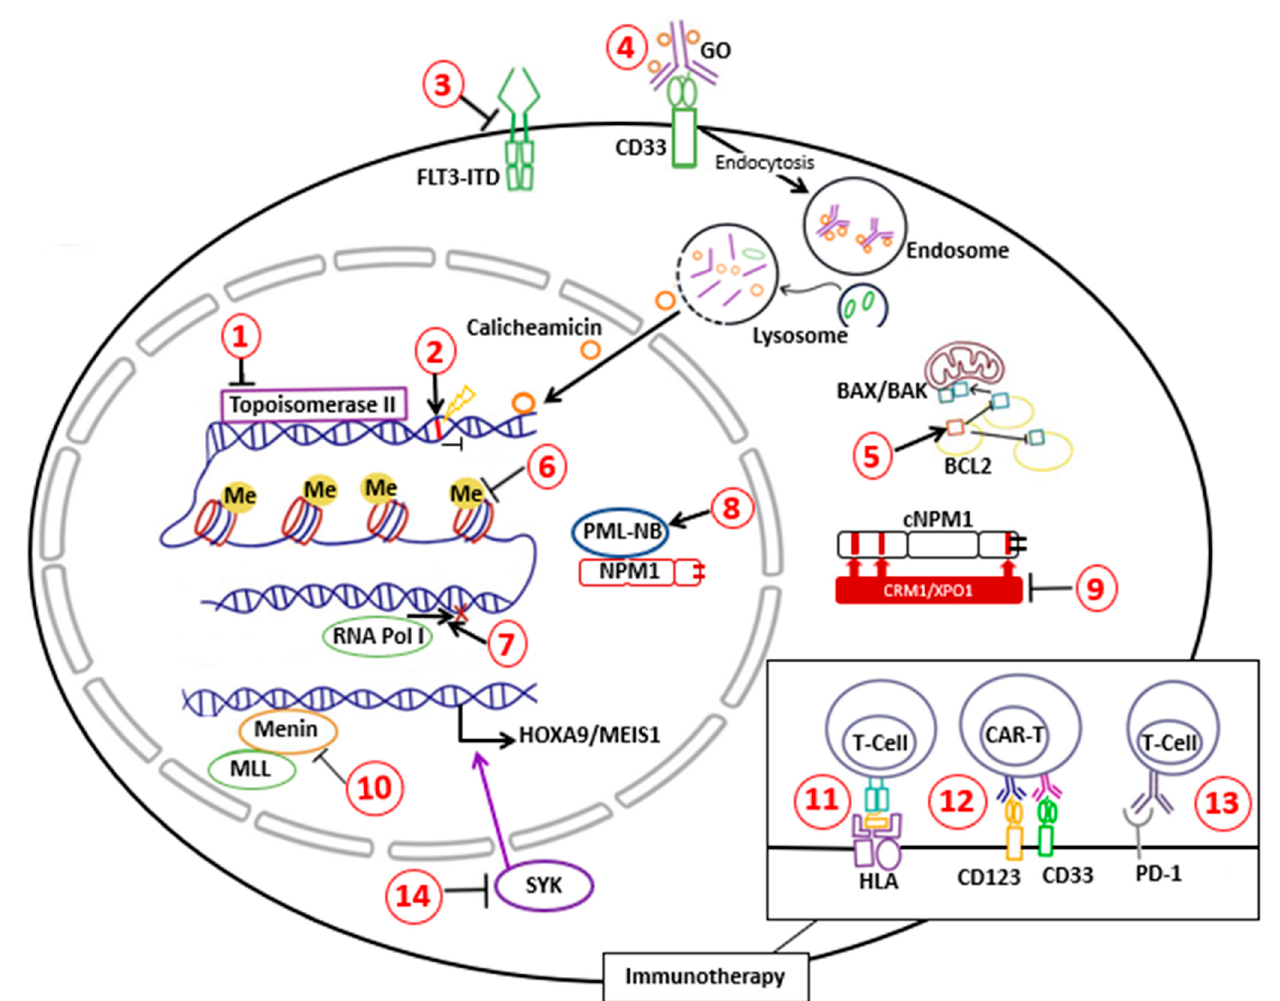
Figure 3. Targeted therapy for NPM1 -mutated AML. ( 1 ) Anthracycline, ( 2 ) Cytarabine, ( 3 ) FLT3 in- hibitors, ( 4 ) Gemtuzumab ozogamicin (GO), ( 5 ) Venetoclax, ( 6 ) Hypomethylating agents (Azacitidine), ( 7 ) Actinomycin D/Dactinomycin, ( 8 ) Arsenic trioxide and ATRA, ( 9 ) XPO1 inhibitors (Leptomycin) with cytoplasmic NPM1 (cNPM1), ( 10 ) Menin inhibitors disruption of Menin with histone methyl- transferase MLL1 (KMT2A), Immunotherapy located on cell membrane: ( 11 ) HLA-dependent T cell immunotherapy, ( 12 ) CAR-T immunotherapy, ( 13 ) Anti-PD-1 immunotherapy, and ( 14 ) SYK